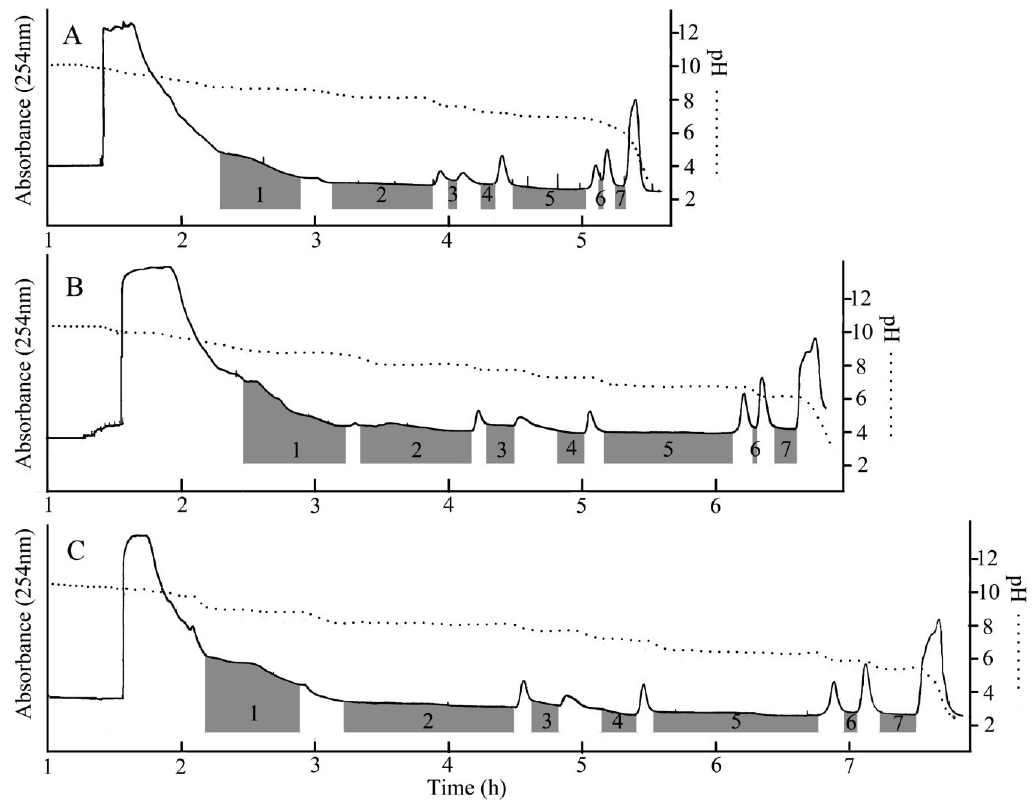
Figure 2. pH-zone-refining CCC chromatograms of preparative separation of alkaloids compounds from Aconitum coreanum (Lèvl.) Rapaics; Condition: ( A ) Two-phase